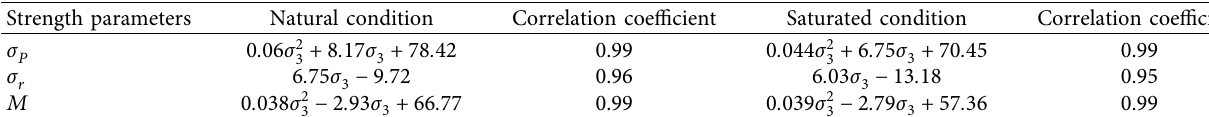
Table 5: Fitted formulas for peak strength, residual strength, and softening modulus of Yunnan limestone under natural and saturated conditions.